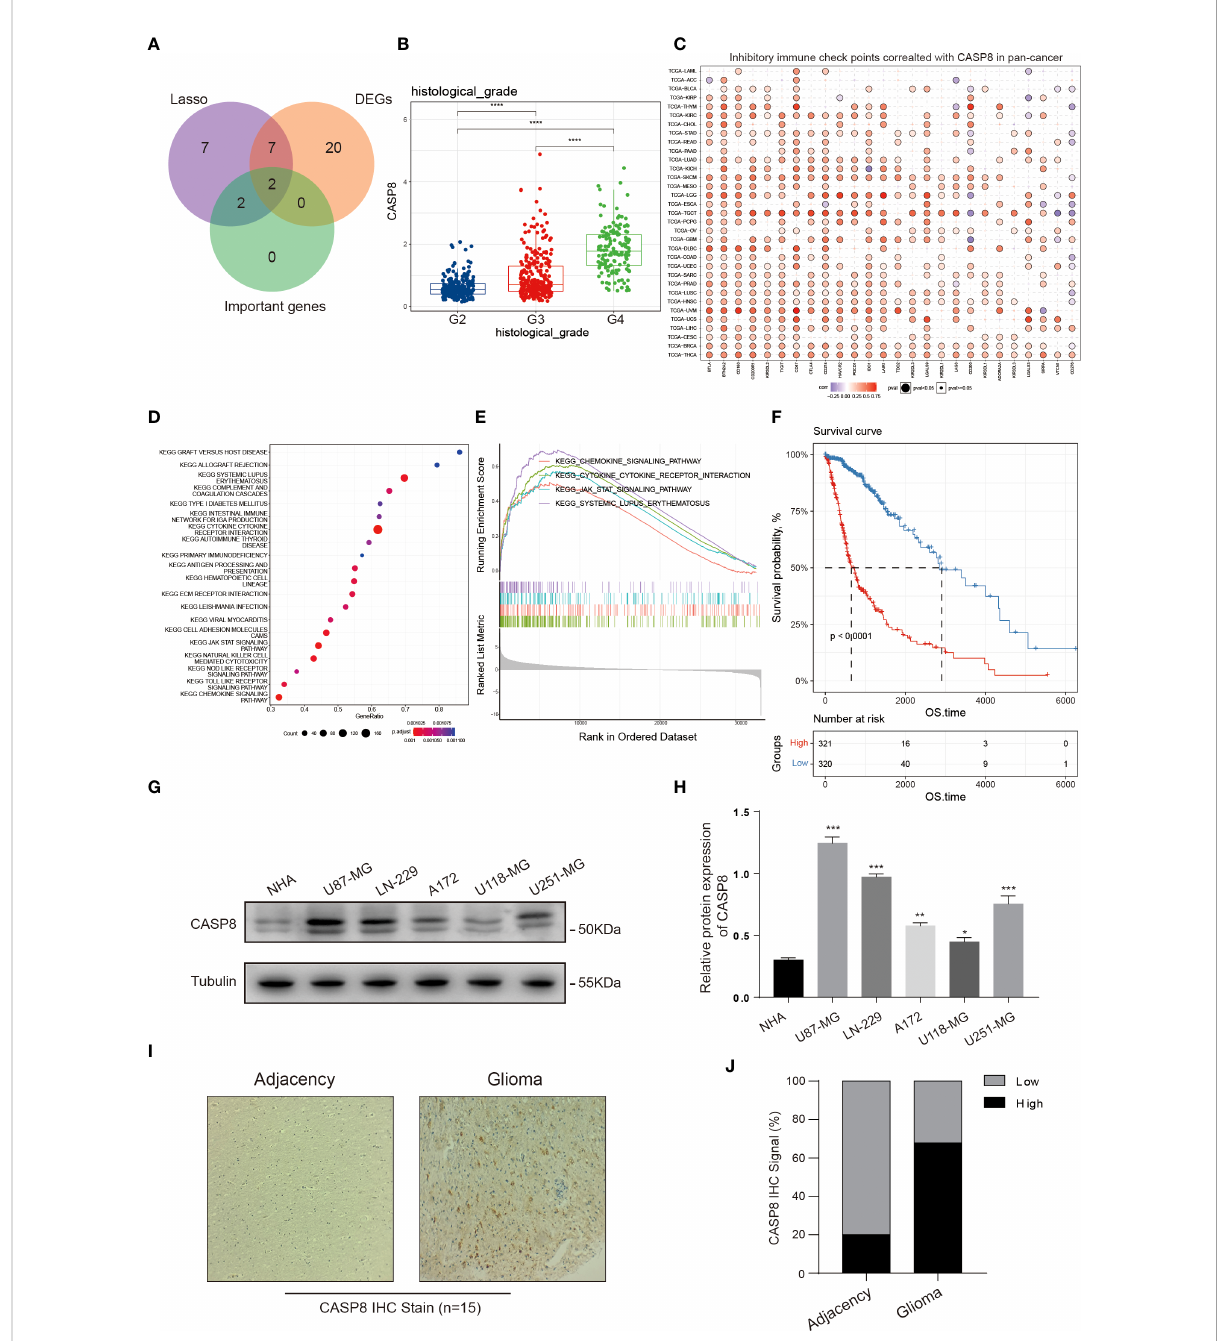
FIGURE 10 CASP8 functional exploration. (A) Venn plot portraying the common genes in the NRS, DEGs, and random forest analysis. (B) The expression of CASP8 was positively correlated with glioma patient histopathological grades (II-IV). (C) Heat map displaying the relationship between various inhibitory immune checkpoints and CASP8 expression in pan-cancer. (D, E) KEGG and GSEA enrichment analyses showing CASP8 -related signaling pathways and biological processes in glioma. (F) The K-M curves suggested that the high CASP8 expression was associated with low overall survival of glioma patients. (G, H) The protein expression of CASP8 in astrocyte NHA and fi ve human glioma cell lines was detected by WB assay, and the protein expression level was quanti fi ed in the histogram. The CASP8 protein expression level is lower in glial cell than glioma cell lines. (I, J) IHC stain was performed on the 15 glioma patient tissues. Compared with the adjacency, the positive IHC signal of CASP8 was more in the glioma tissues. * p<0.05; ** p<0.01; *** p<0.001 and ****